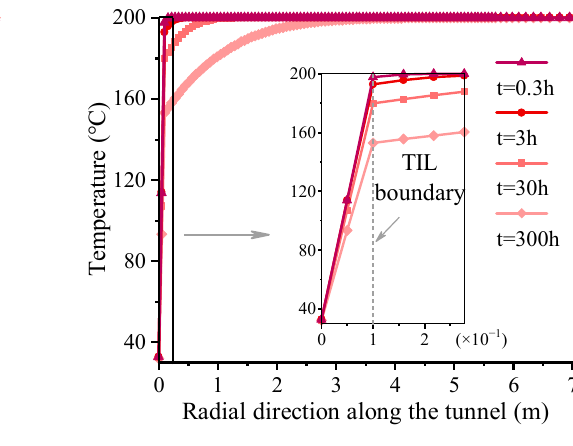
Figure 14. Temperature radially distributed across ventilation entrance along with time. At the end of ventilation cooling, the stress state of surrounding rock along the radial but horizontal direction on the circular tunnel cross-section is exemplified in Figure 15. The falling off of surrounding rock temperature causes additional tensile stress near the tunnel. The reduction of minimum principal stress leads to further rock damages and then descending of the compressive stress which can hold its burden. The rock in the temperature lowered zone shrinks and is unloaded so the concentration of compressive stress transfers to further zone.